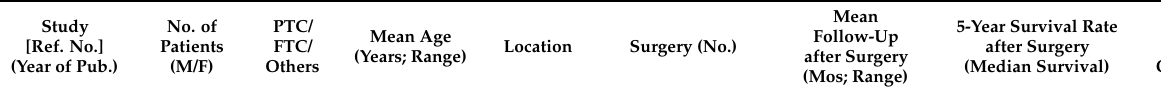
Table 1. Clinical outcomes of surgery for thyroid cancer BMs published in the last 10